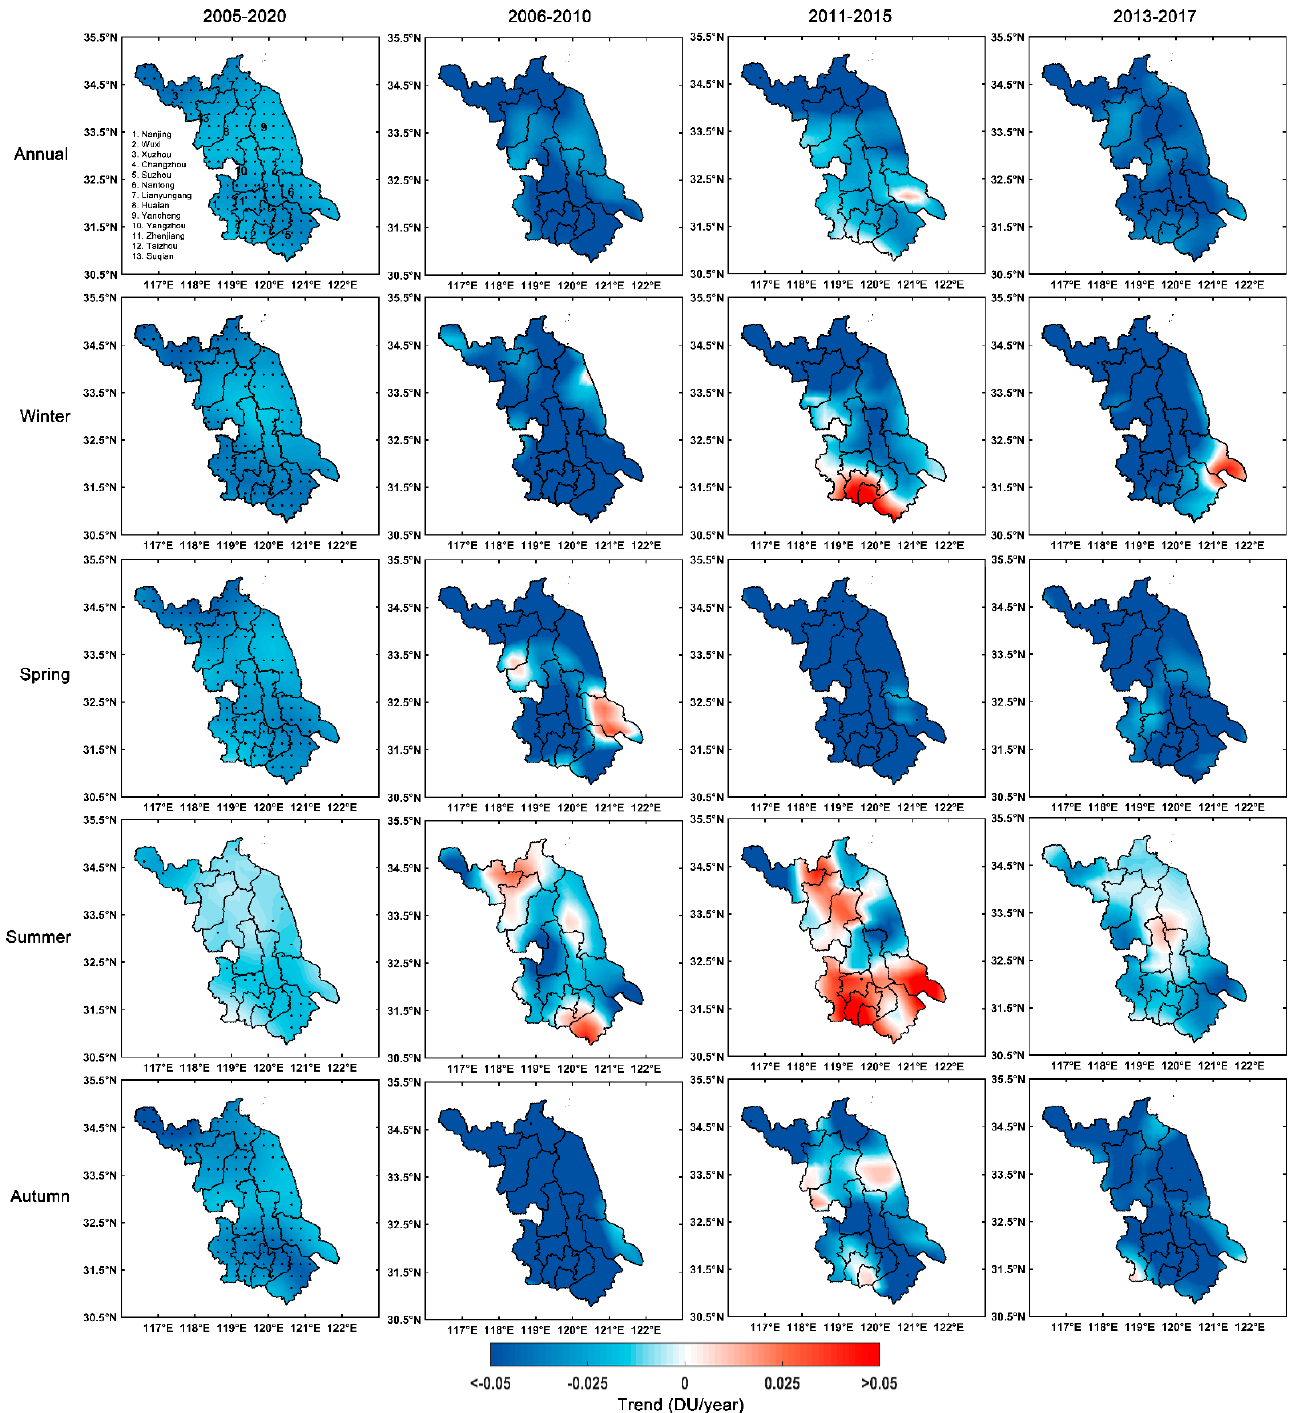
Figure 8. Annual and seasonal spatial trends in OMI-based total column SO 2 (DU/year) for the periods of 2005 − 2020, 2006 − 2010, 2011 − 2015, and 2013 − 2017 in Jiangsu Province. The dot (.) indicates significance at a 95% confidence level.